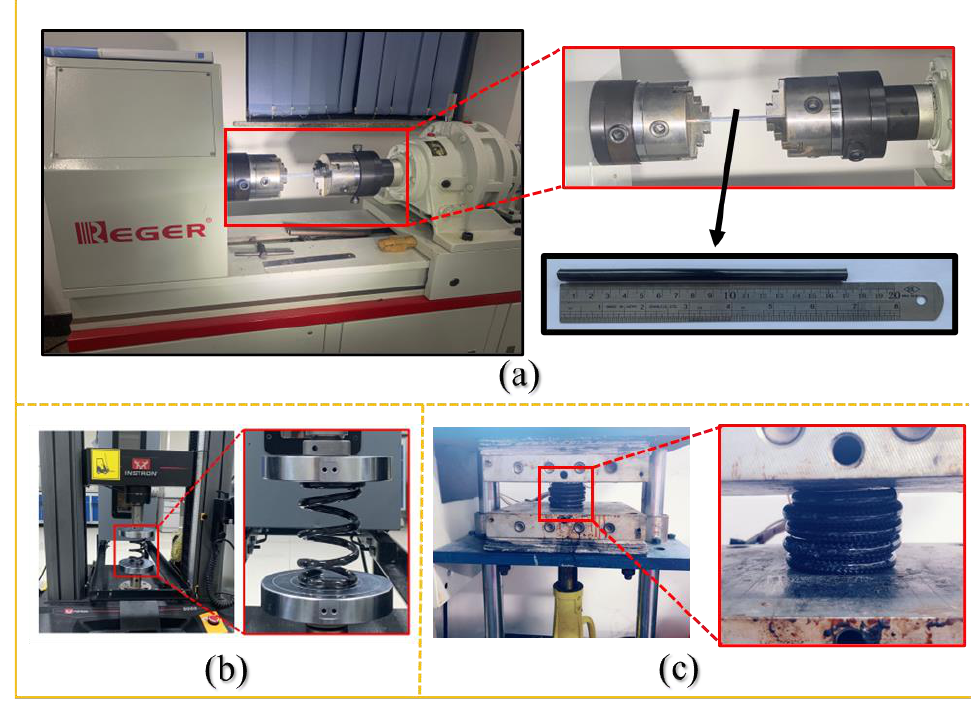
Figure 3. Test setups for ( a ) torsion test of PMCRs, ( b ) compression of PMCHSs, and ( c ) resilience of PMCHSs.